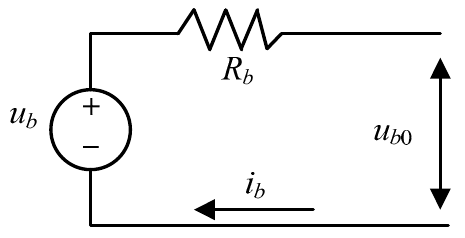
Figure 4. Equivalent model of the single-battery model [19].